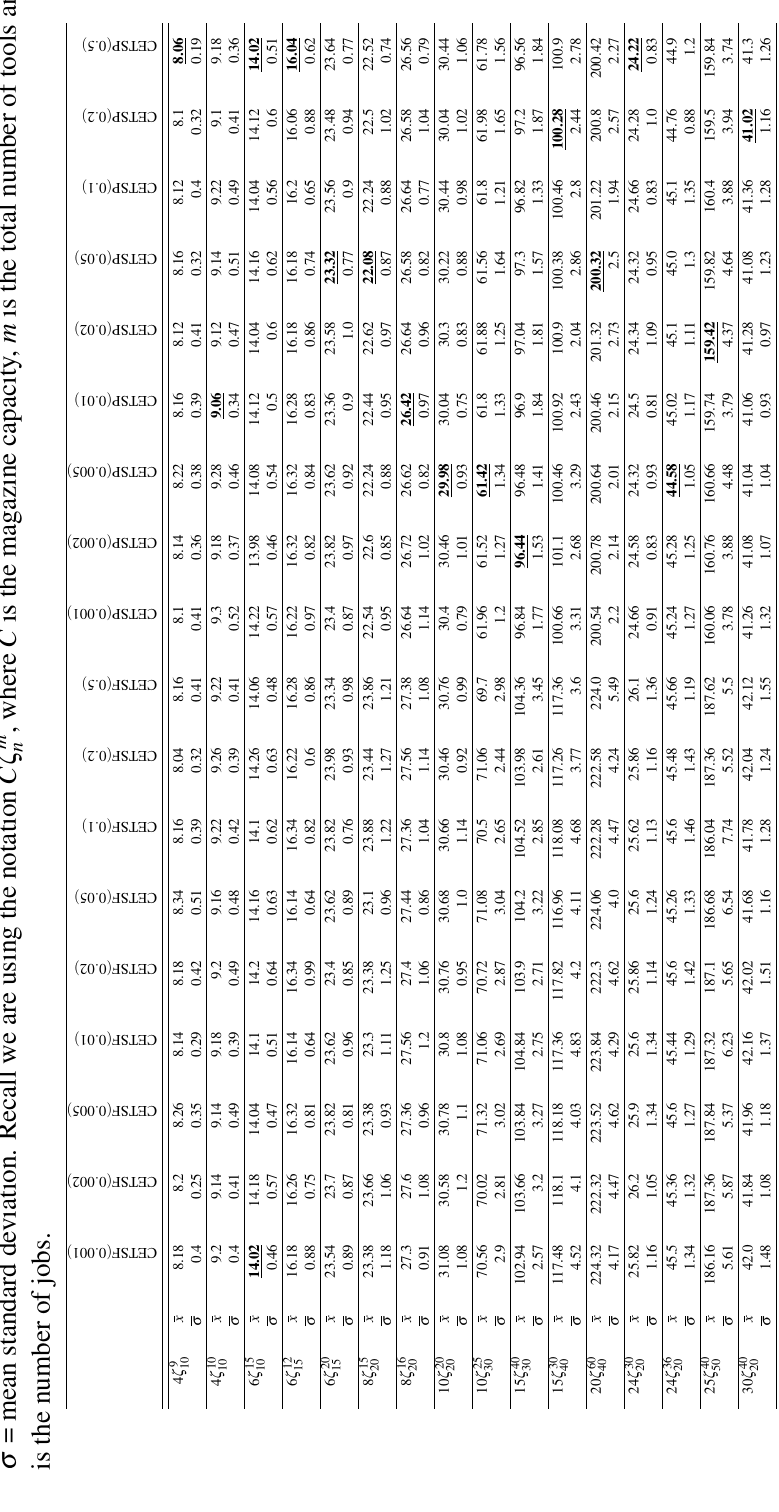
s . ob j o f e r b m nu